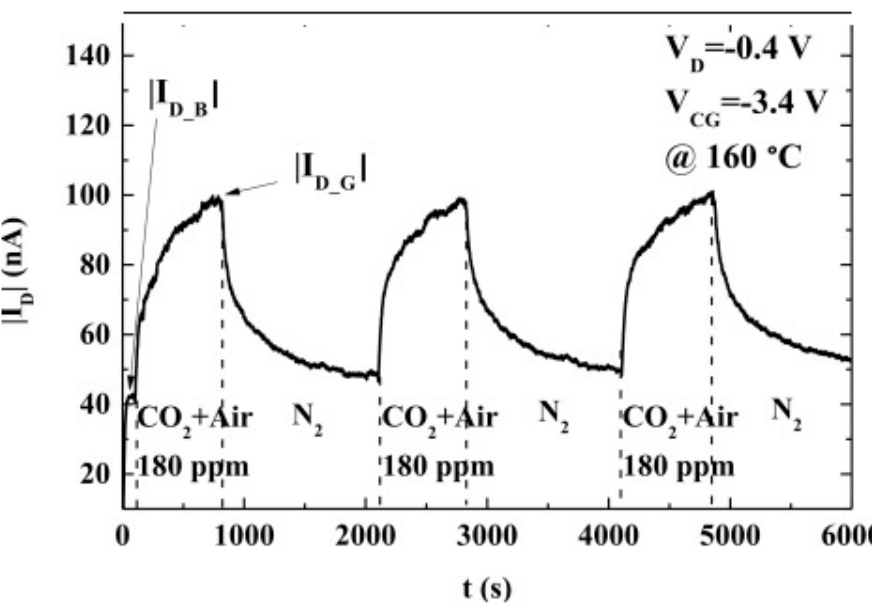
Figure 27. Type 3 inkjet-printed sensor for CO 2 operating at 160 °C. I D : drain current. Responds to CO 2 concentration. V D and V CG are drain and gate voltages. Reproduced with permission from Reference [121].